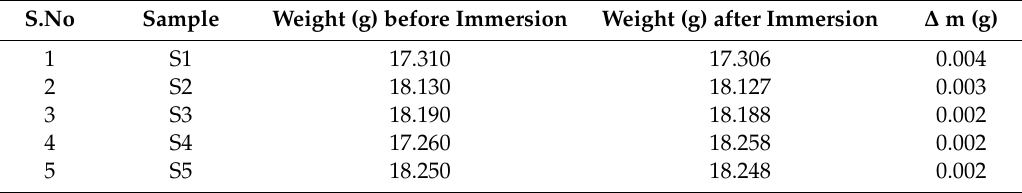
Table 3. Weight loss measurements for all samples in artificial saliva solution.